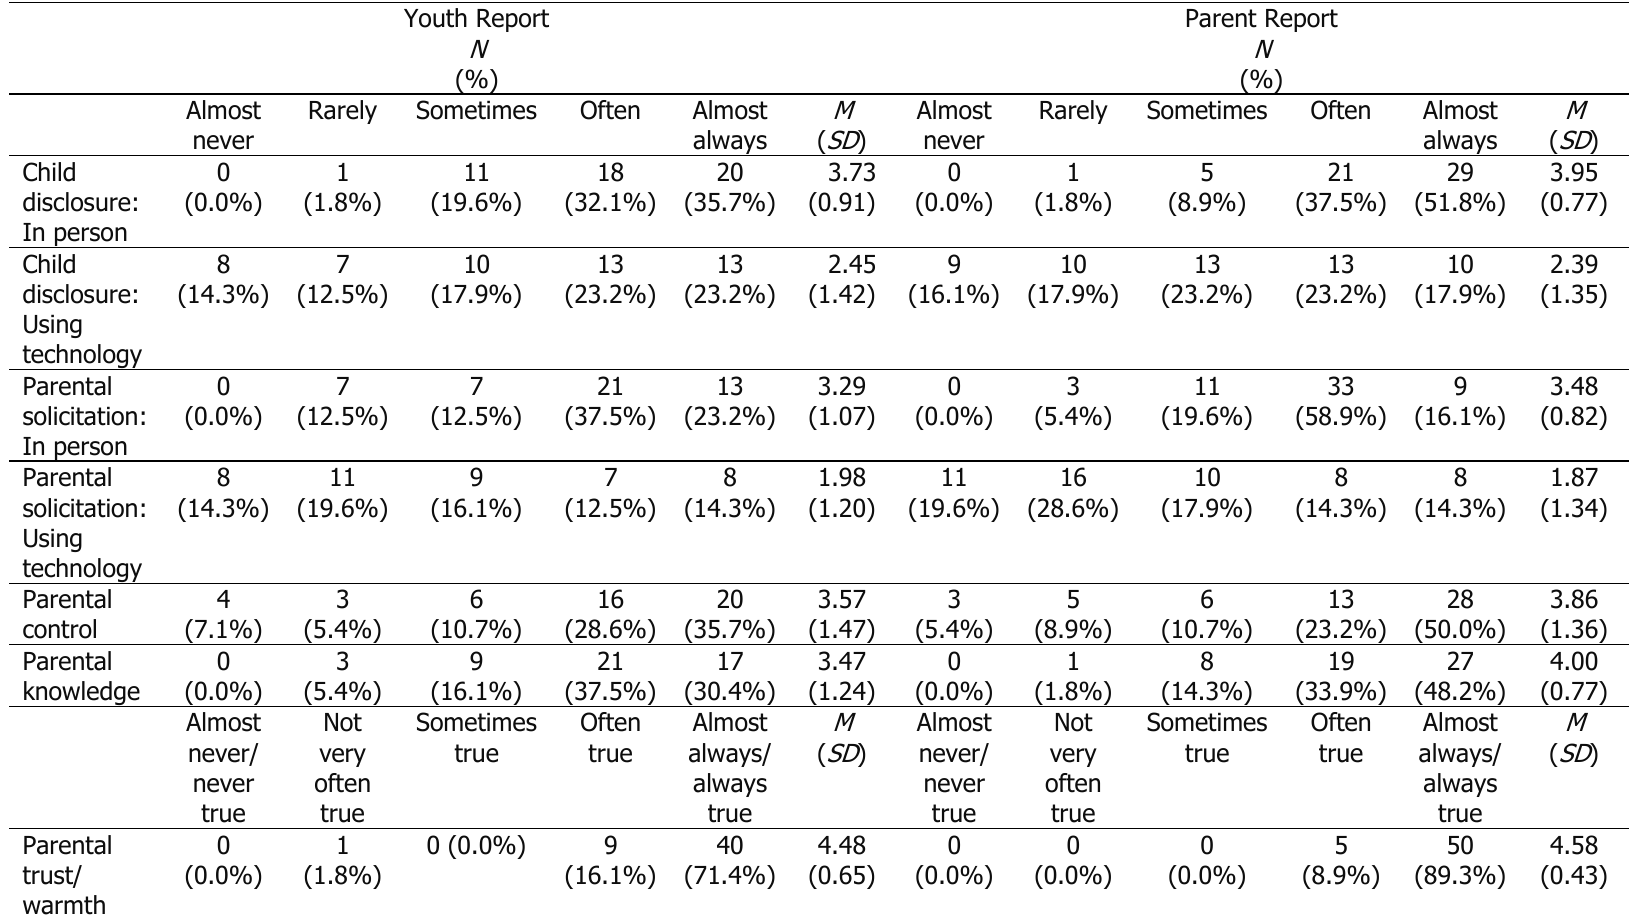
Table 2. Frequencies of Youth and Parent Report of Child Disclosure and Parental Solicitation in Person and Using Technology (N =